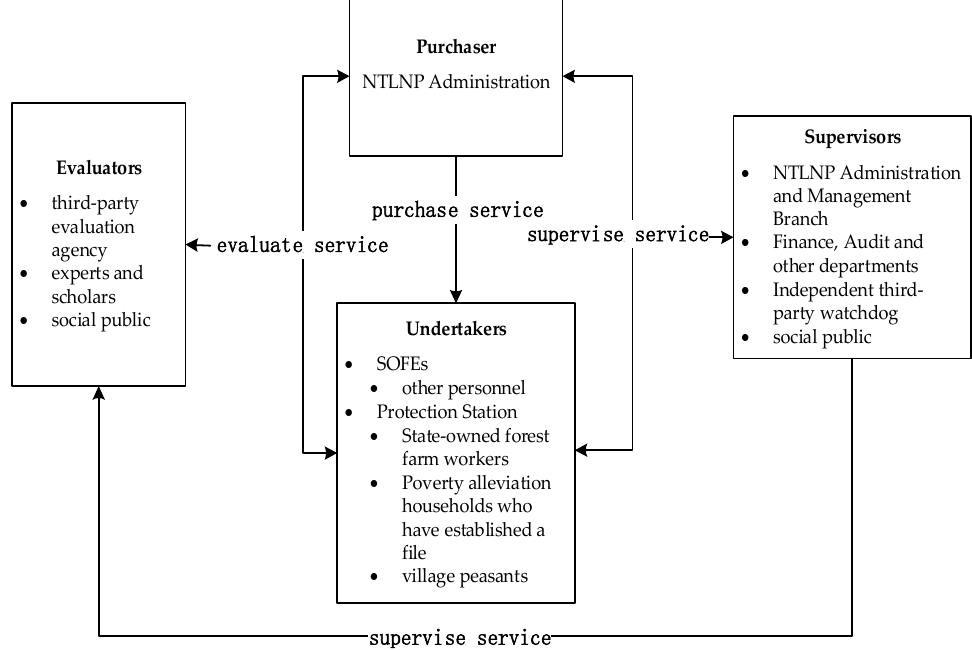
Figure 4. Construction of government purchasing ecological services responsibility